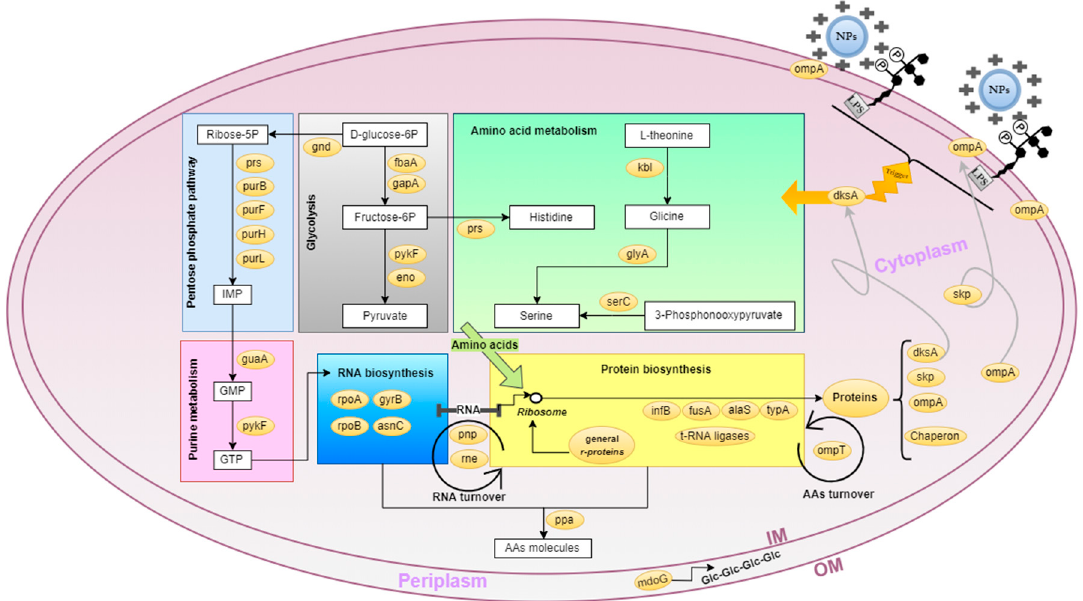
Figure 5. Schematic diagram of upregulated E. coli proteins and pathways in response to CS nanoparticles/polymers sensibilization. Arrows indicate positive regulation, yellow circles represent upregulated proteins; NPs, nanoparticles; LPS, Lipopolysaccharides; IM, inner plasmatic membrane; OM, outer plasmatic membrane; Glc, glucans and AAs amino acids. The proteins genes comprise the chaperone group, bamA, dnaK, hslU , tig and skp ; t-RNA ligases; ileS, pheS, pheT and tsf and general r-proteins, rplA, rplB, rplC, rplE, rplF, rplI, rplJ, rplK, rplL, rplM, rplO, rplS, rplT, rplU, rplV, rpmA, rpmB, and rpmD.